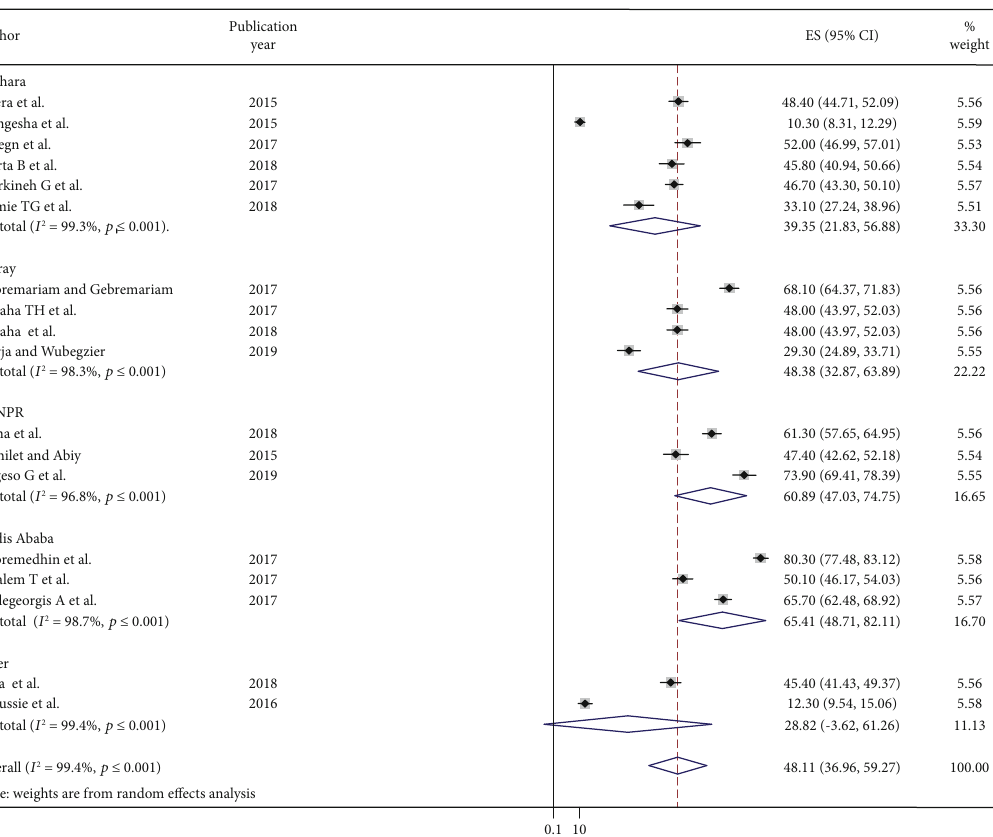
Figure 3: The subgroup analysis of postpartum contraceptive use status by regional states in Ethiopia,